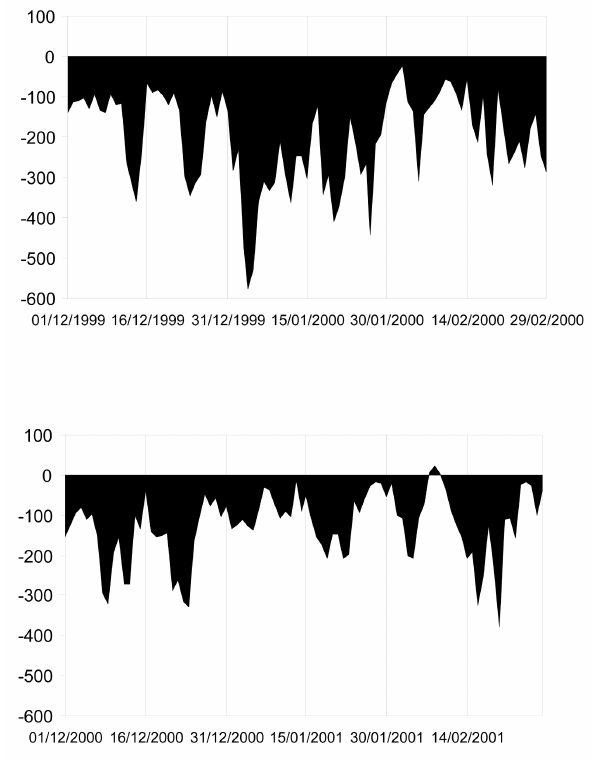
Fig. 5. Temperature and salinity profiles measured in situ during the maintenance cruise of 1 August